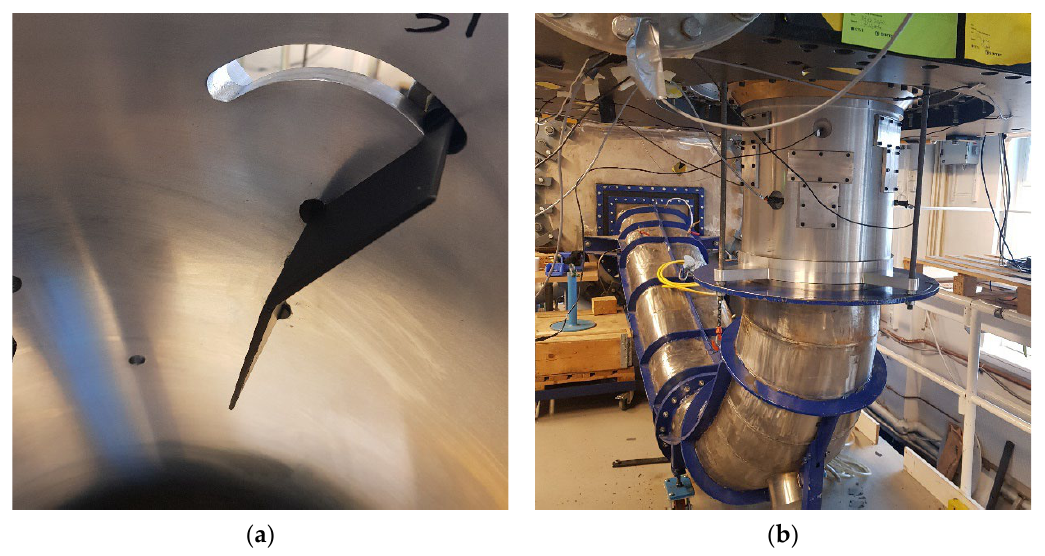
Figure A1. ( a ) Guide vanes inside the draft tube, showing the adjustability of the upper hydrofoil and fixed lower hydrofoil. ( b ) Complete Francis-99 draft tube.